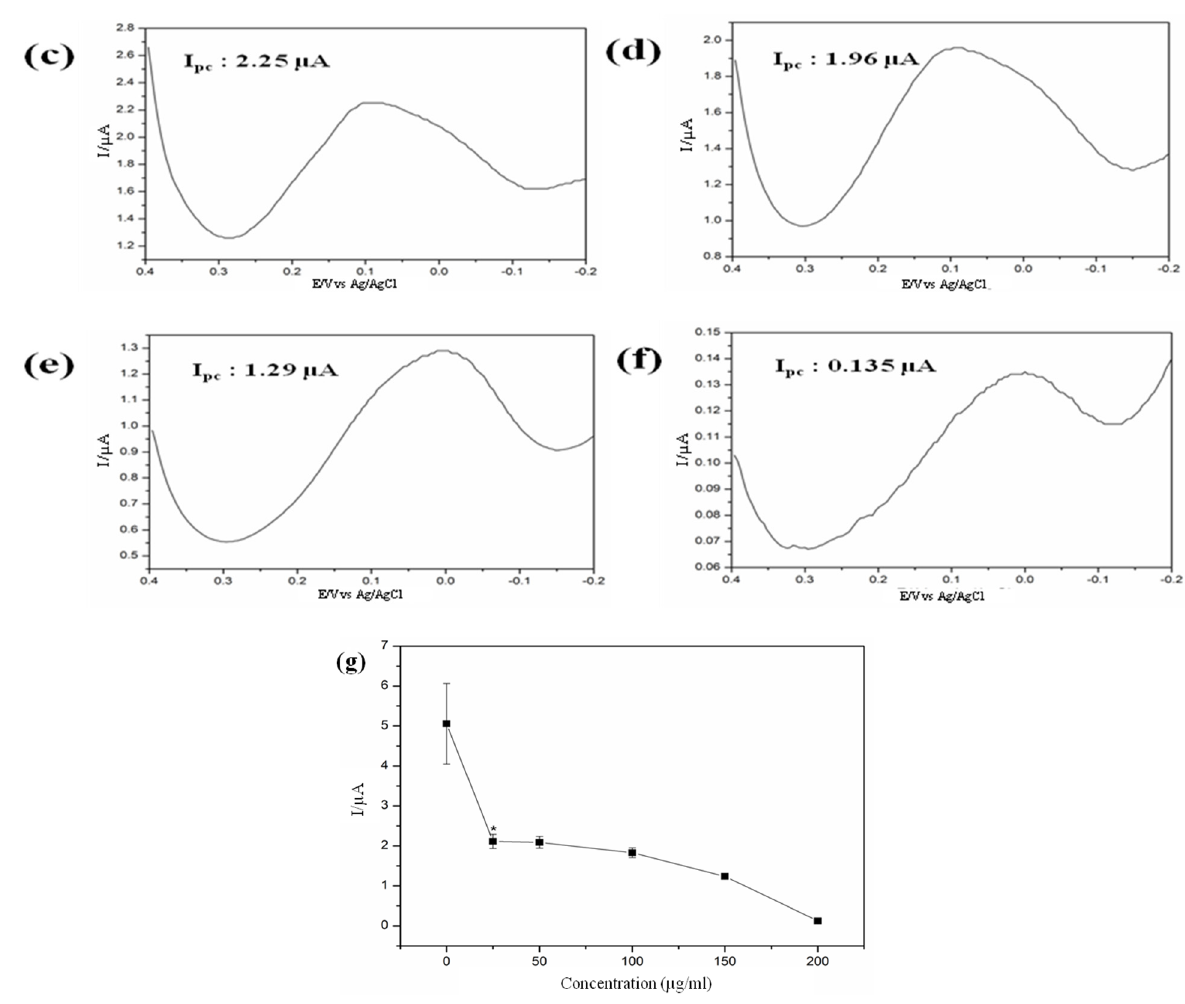
Figure 11. Electrochemical responses of HB1.F3 cell treated with ( a ) 0 μ g/mL; ( b ) 25 μ g/mL; ( c ) 50 μ g/mL; ( d ) 100 μ g/mL; ( e ) 150 μ g/mL and ( f ) 200 μ g/mL of GO nano-pellets obtained via DPV; ( g ) Decreases in the peak current of the DPV signal that corresponded to different concentrations of GO nano-pellets with which the HB1.F3 cells were treated ( * p < 0.05 vs . the control; the error bars stand for the standard deviation